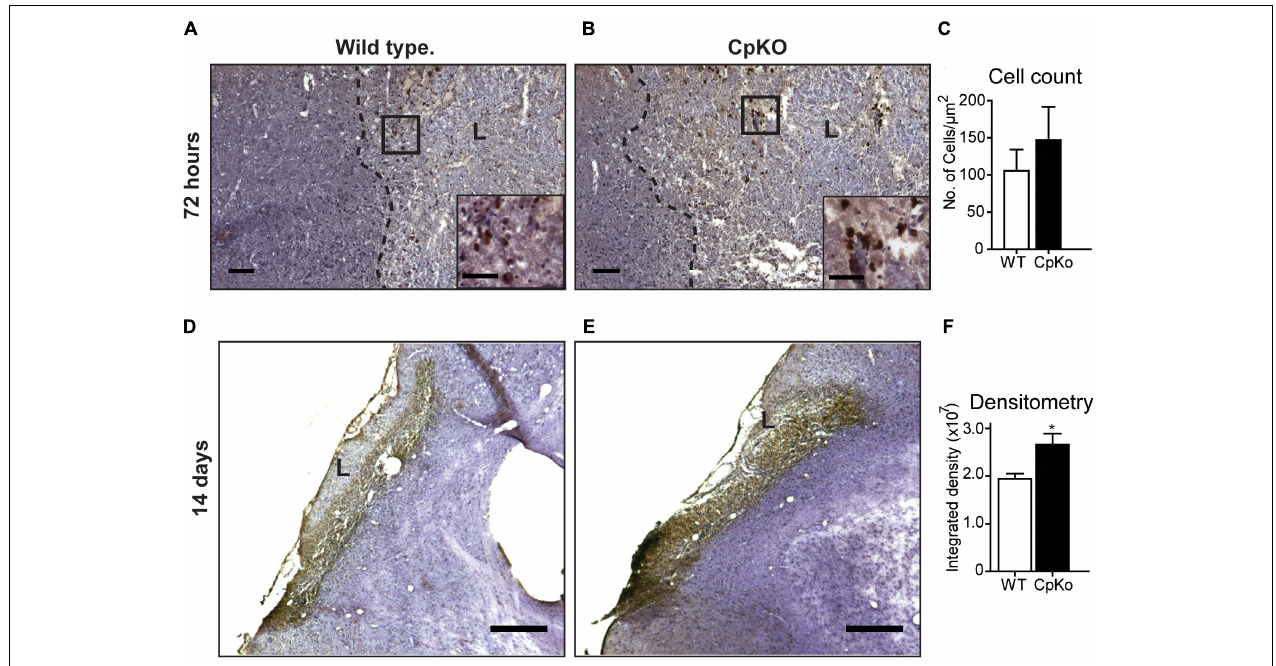
FIGURE 4 | Iron histochemistry. Detected by the enhanced Turnbull’s staining of tissue sections taken 72 h (A–C) and 14 days (D–F) after pMCAO. At 72 h the cells labeled for iron (stained dark brown; see insets in A and B ) are located in the lesion and distributed along the lesion border in both wildtype (A) and CpKO (B) mice; L = lesion; areas in the black squares in A,B are shown at higher magnification in the insets. (C) Graph shows that the number of iron+ cells is not significantly different in the two genotypes. At 14 days (D,E) the iron labeled cells are densely packed in the lesion (L) making it difficult to do cell counts. Densitometric analysis (F) showed higher levels of iron deposition in CpKO mice compared to wildtype mice at 14 days. All sections counterstained with Mayer’s hemalum stain. Scale bars in A–E = 100 µ m, inset = 50 µ m; n = 6 per group; ∗ p -value ≤